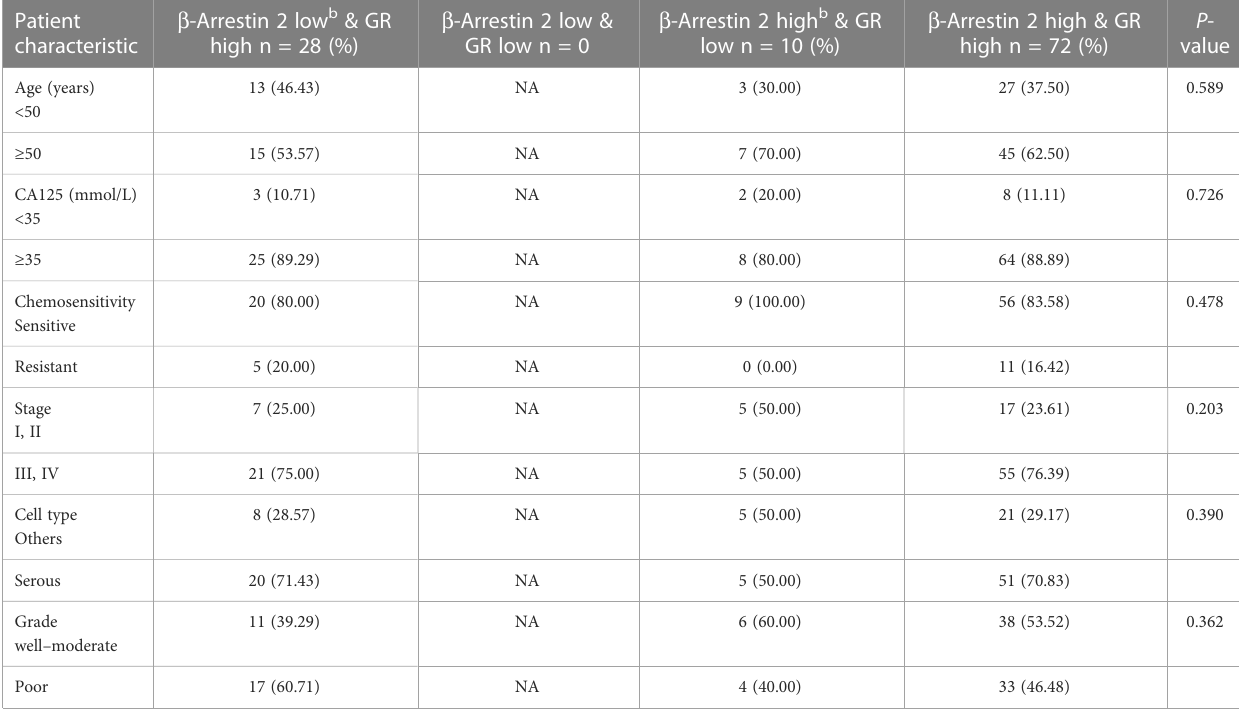
analyzed b -arrestin expression using GEO data (Supplementary Figure S2). In GSE14407, the expression of b -arrestins 1 and 2 was higher in tumor specimens than in normal tissues, which is consistent with the present study fi ndings (Supplementary Figure S2A). However, in GSE26712, b -arrestin 1 was expressed at lower levels in tumor specimens than in normal tissues (Supplementary Figure S2B). In GSE16570, containing data of clear cell tumors, b -arrestin 2 was expressed at lower levels in tumor specimens than in normal tissues (Supplementary Figure